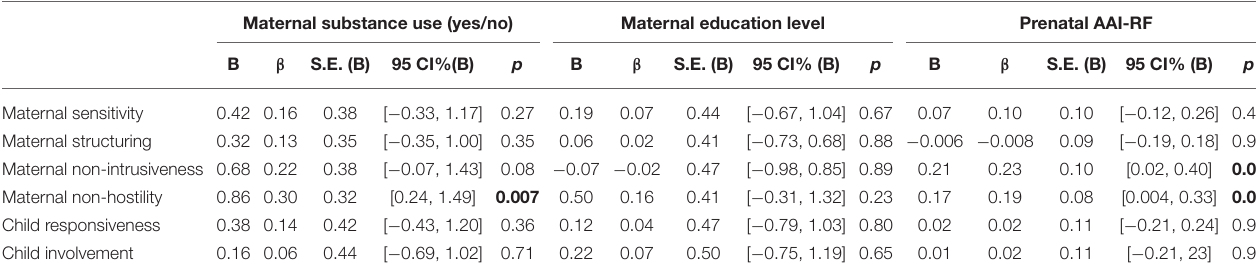
TABLE 6 | Associations between maternal prenatal AAI-RF and change in maternal and child EA from 4 to 12 months. Maternal substance use (yes/no) Maternal education level Prenatal AAI-RF